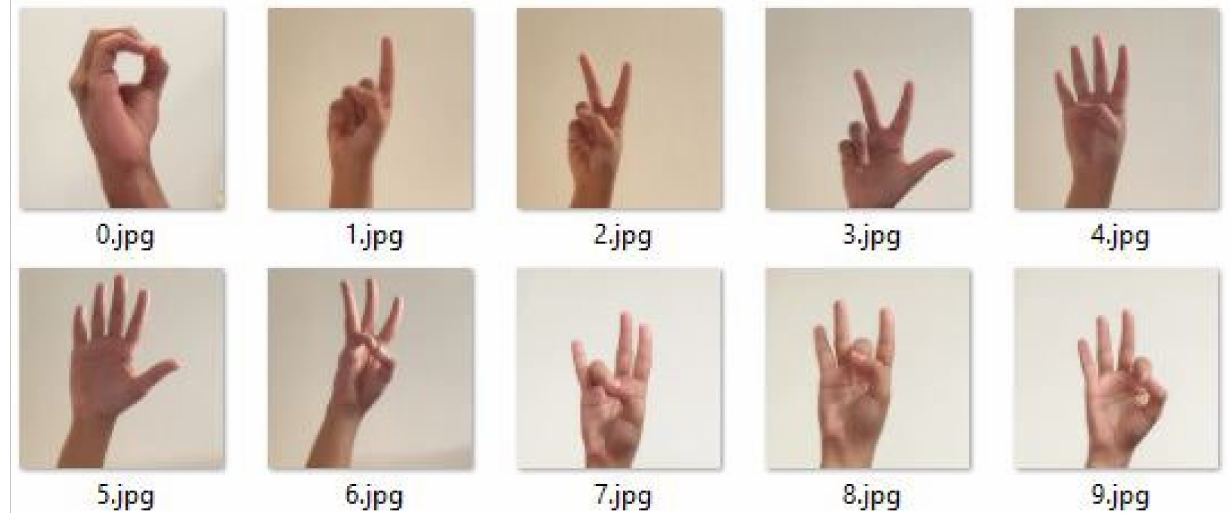
Figure 3. The sample image from Dataset